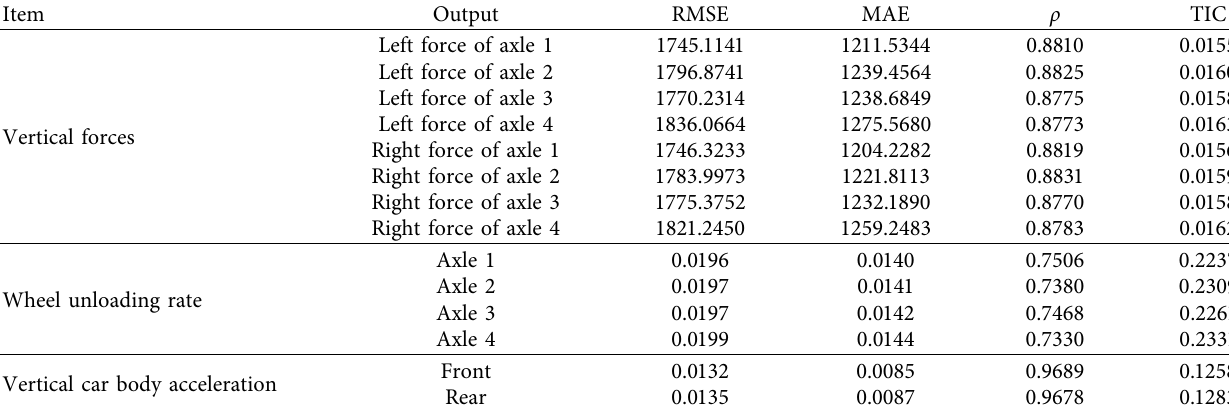
Table 3: Accuracy indices of the vehicle response of line 1 in the inspection-simulation dataset.